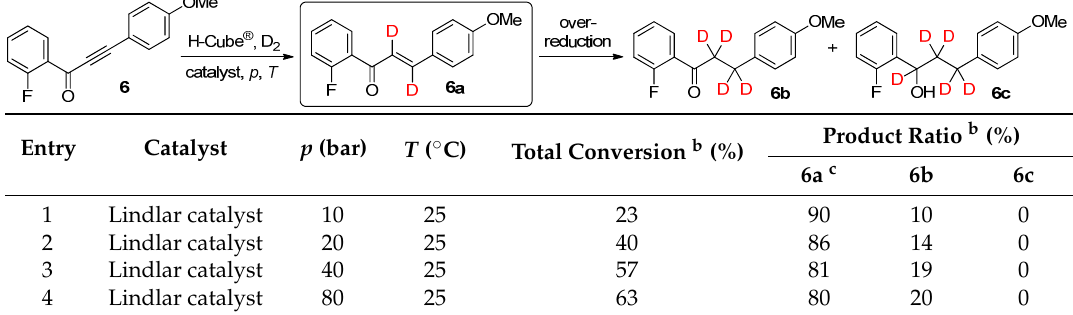
Table 2. Continuous-flow deuteration of 6 a .